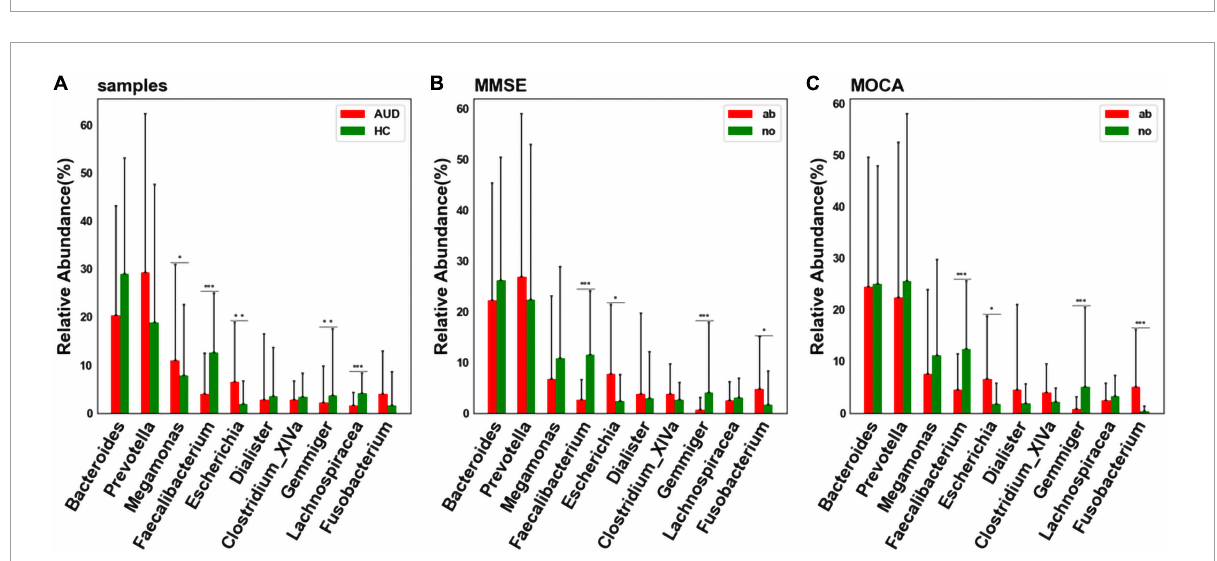
FIGURE4 Differential bacterial screening for different sample distributions. (A) Comparison of differences in major bacteria at the genus levels between AUD and HC groups; (B) screening of differential bacteria by MMSE Score; (C) screening of differential bacteria by MoCA Score [*indicates statistical differences ( P < 0.05), **( P < 0.01), *** ( P <